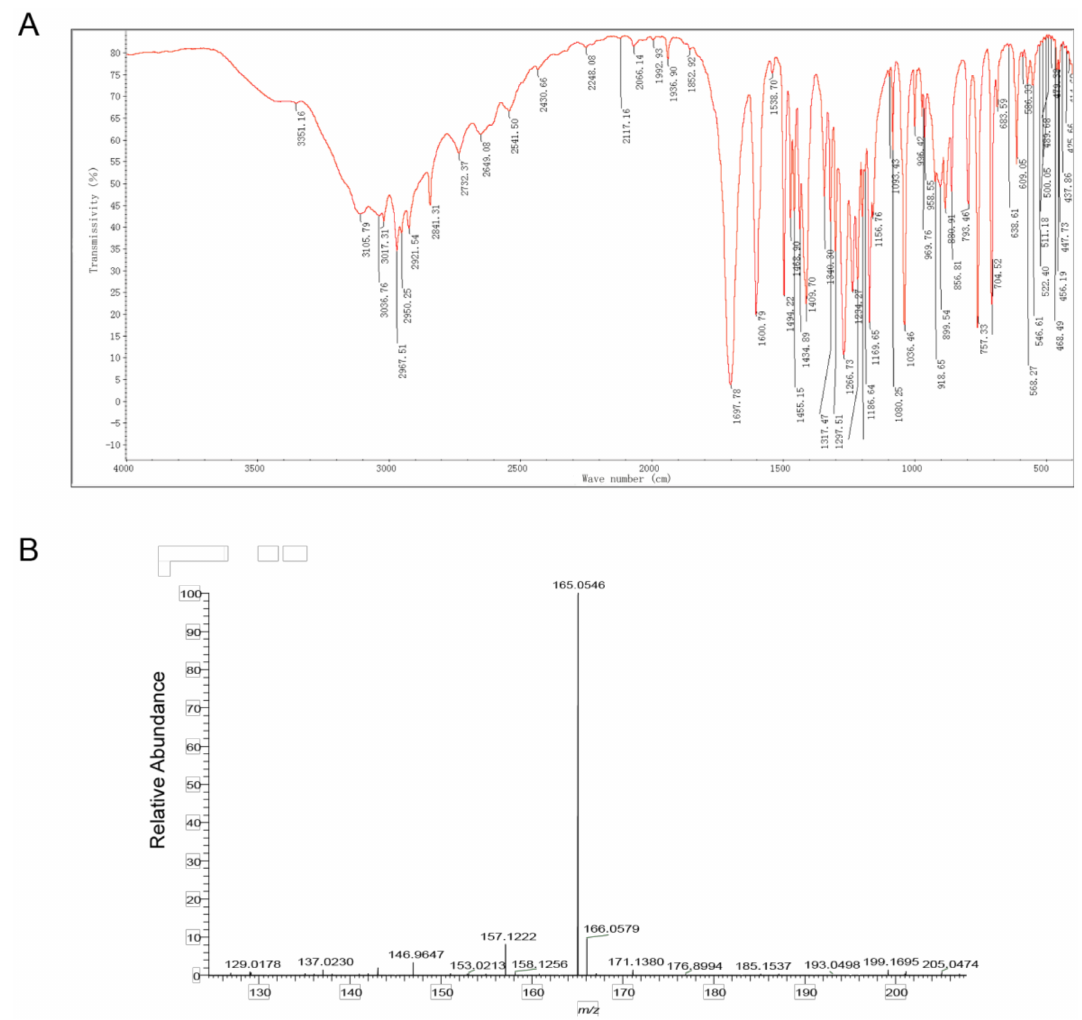
Figure 3. Identification of toxin compound by IR and mass spectrometry from R. solani AG-3 TB.